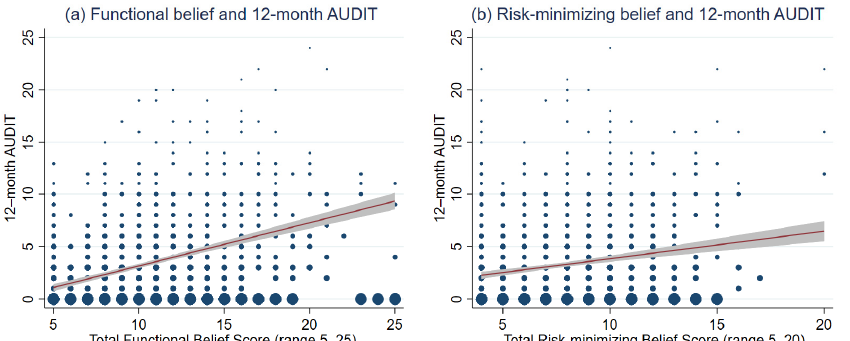
Figure 1. Scatter plots visualizing correlation between health beliefs and 12-month alcohol-use disorders identification test (AUDIT) score. ( a ) Monotonic correlation between functional-belief score and 12-month AUDIT score, ( b ) monotonic correlation between risk-minimizing belief score and 12-month AUDIT score.